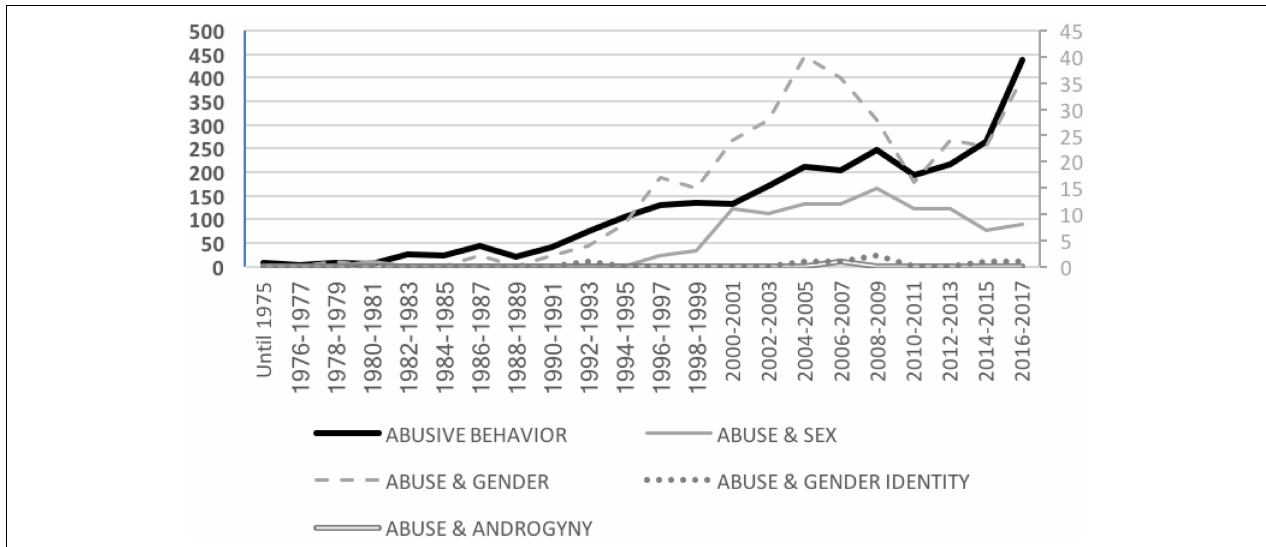
FIGURE 3 | Total number of scientific articles per year about workplace abusive behavior by gender category.